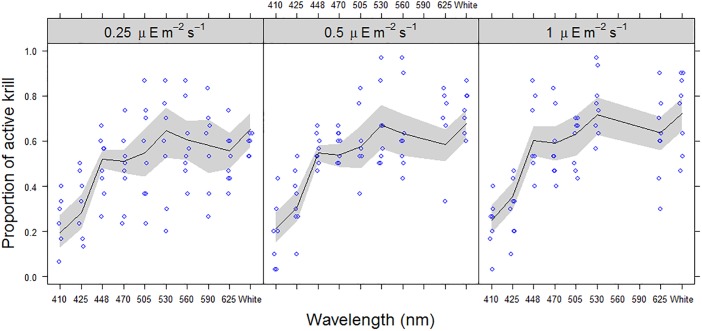
Proportion of active krill related to wavelength and intensity.The proportion of krill (Magenyctiphanes norvegica) observed to be active during replicate treatments (blue circles, jittered) and GEE fitted values (Black line) with 95% confidence intervals (grey shaded band), with respect to wavelength and light intensity (0.25, 0.5 & 1.0 μE m-2 s-1). X-axis is not to scale, and for comparison broadband white light (400-800nm) is displayed at the end.